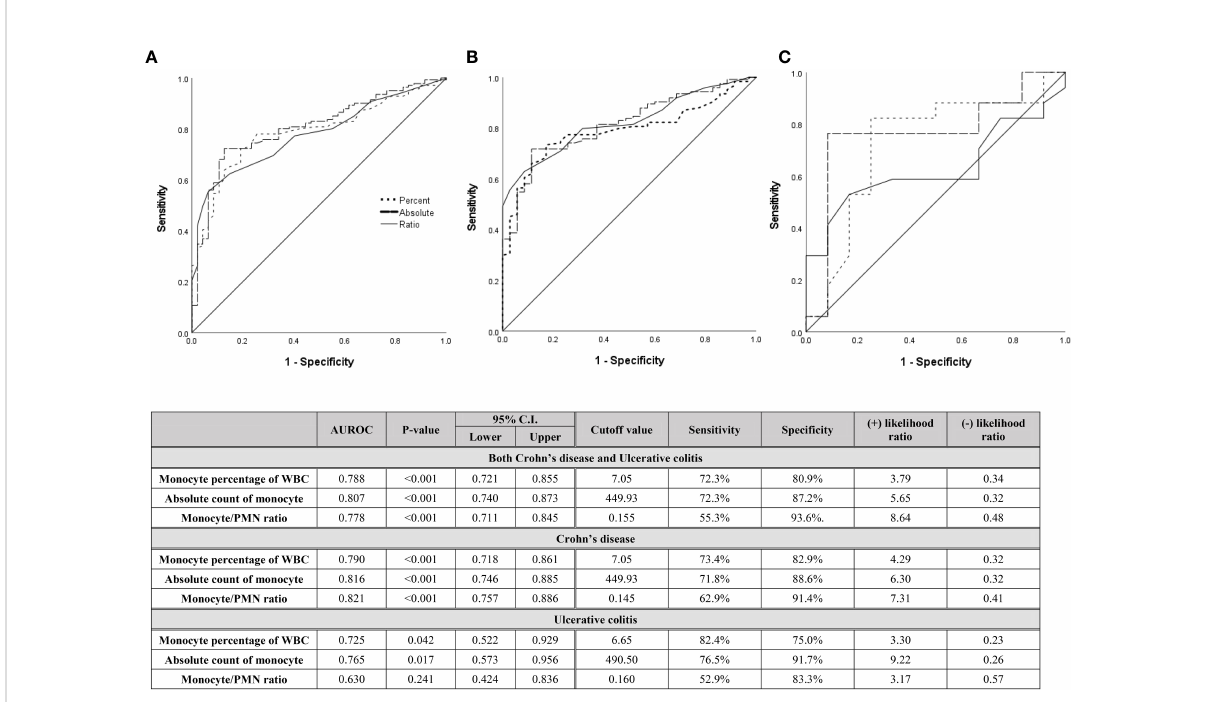
FIGURE 3 Diagnostic capabilities with area under operating characteristic curve of the serum monocyte for assessing relapse in (A) both CD and UC patients, (B) only CD patients, and (C) only UC patients after discontinuation of